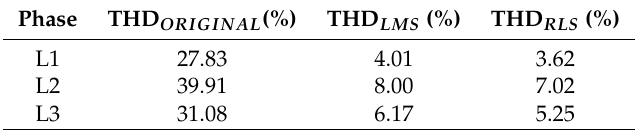
Figure 26. Idle run of test polygon; current waveforms before filtration. Table 2. Idle run THD values before and after application of the adaptive LMS and RLS algorithms.